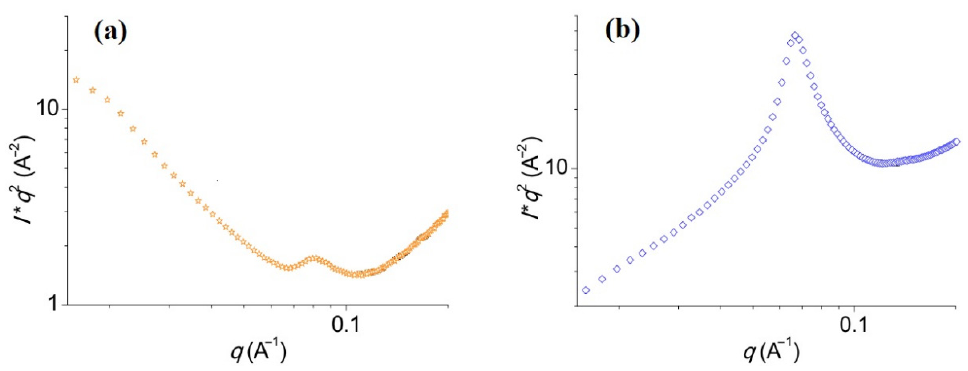
Figure 20. Lorentz-corrected synchrotron SAXS patterns of potato starch particles: ( a ) before hydra- tion; and ( b ) after hydration. Adapted with permission from [170]. Copyright 2017, Elsevier.